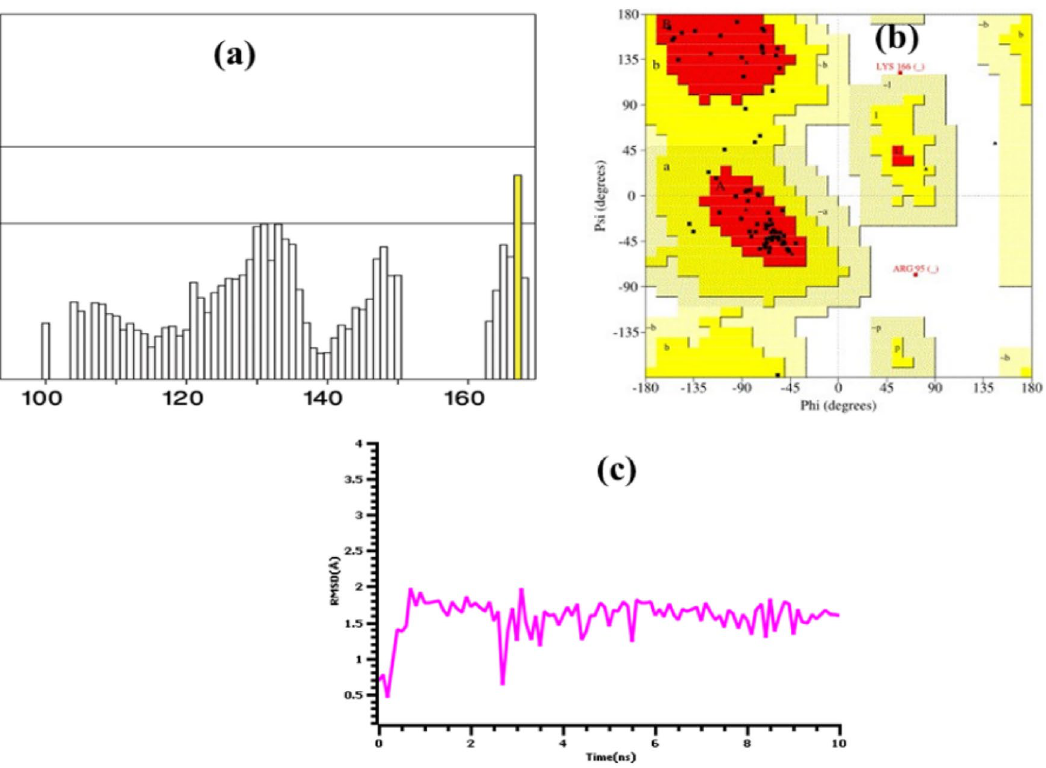
Figure 9. The quality assessments for the model protein, ( a ) ERRAT, where there were 85.55% residues in the allowed regions, ( b ) Ramachandran Plot assessment to validate structural quality, ( c ) root mean square deviation from the C-alpha atoms of the modeled protein, where lower deviations were